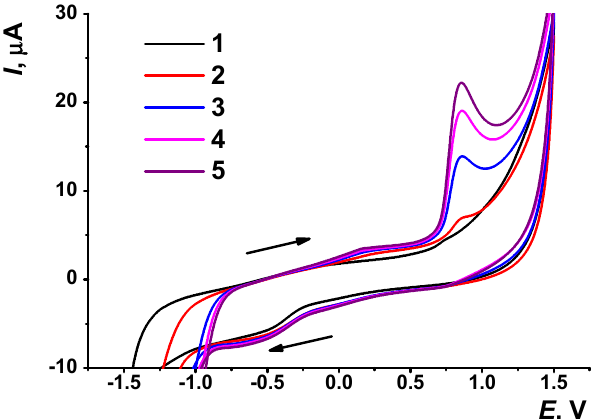
Figure 2. Cyclic voltammograms recorded on the GCE covered with CB (2 µL of 1.35 mg/mL in chitosan) and DNA (20 min incubation) in 1.0 µM AY solution in phosphate buffer, pH 4.0. The numbers (1–5) correspond to the number of potential scan performed after the immersion of the electrode in the dye solution. Arrows indicate the direction of the potential scan, 100 mV/s.